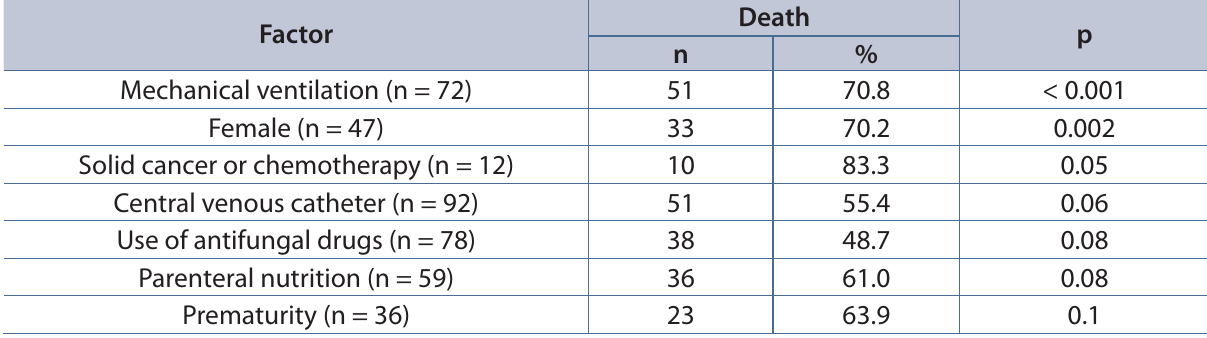
Table 6. Mortality rates and factors associated with candidemia in patients admitted to Botucatu